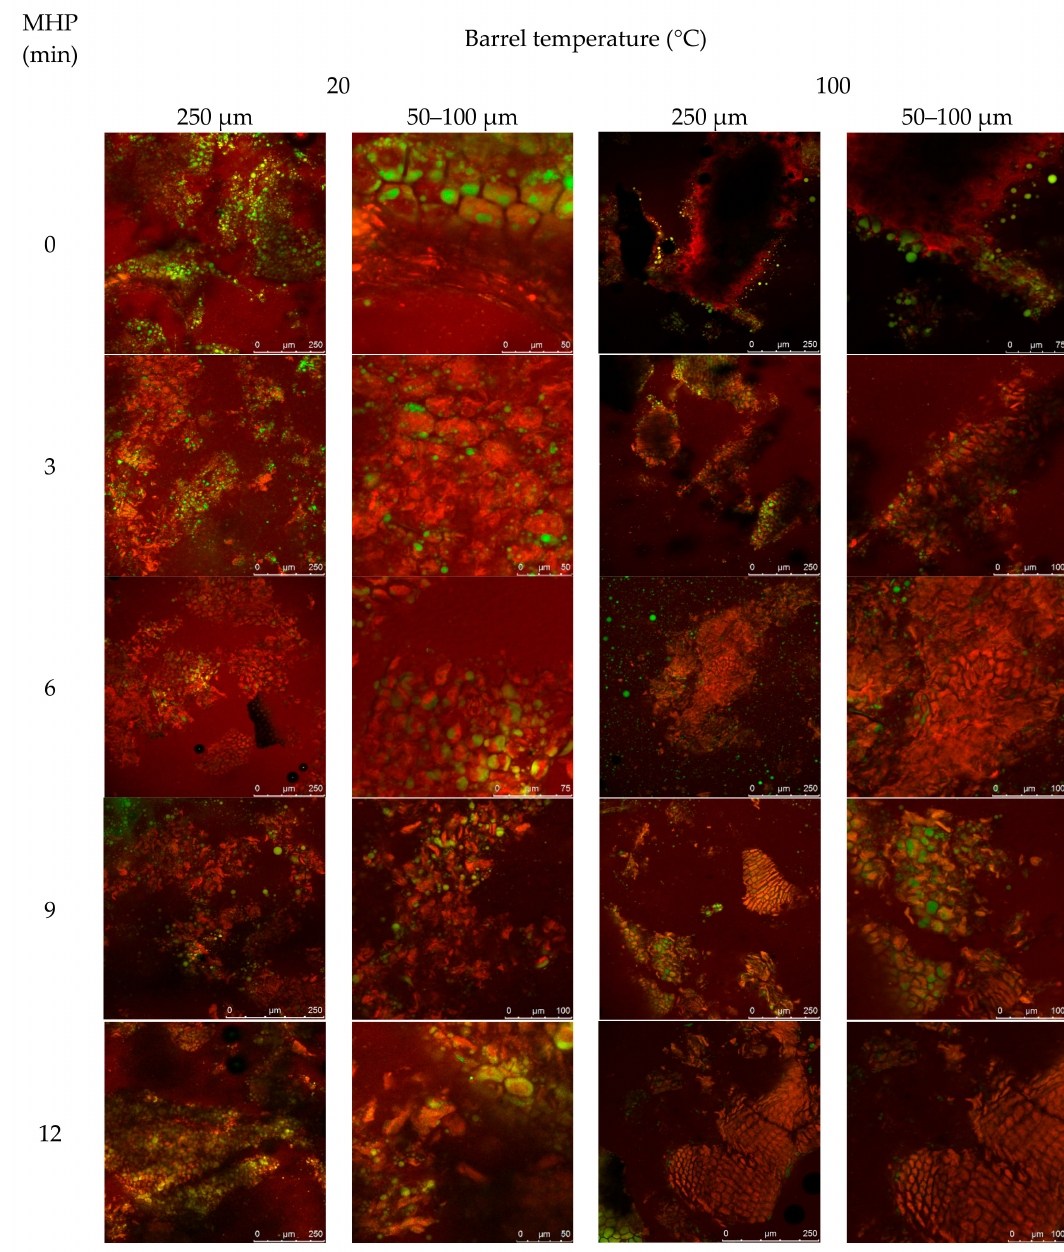
Figure A3. Representative confocal laser scanning micrographs of cold-pressed (20 ◦ C) and expeller (100 ◦ C) canola meal treated with increasing durations of moist heat pressure (MHP, 0–12 min) and proteolytic digestion. Protein is stained red with Nile Blue dye, and lipid is stained green with Fast Green FCF dye. Scale bars correspond to 250, 100, 75 or 50 µ